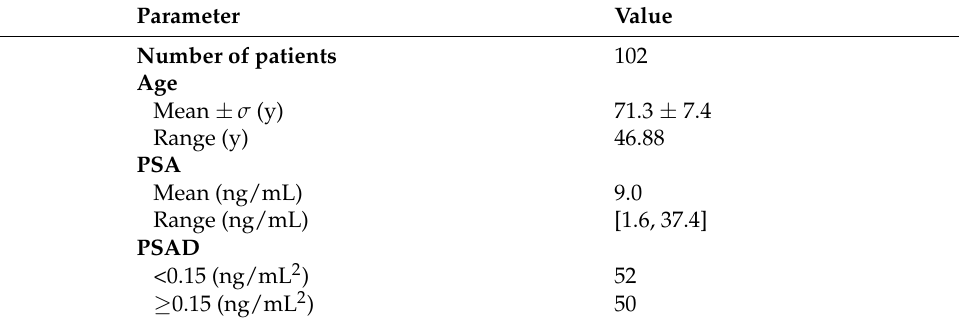
Table 1. Clinical characteristics of the patient cohort.